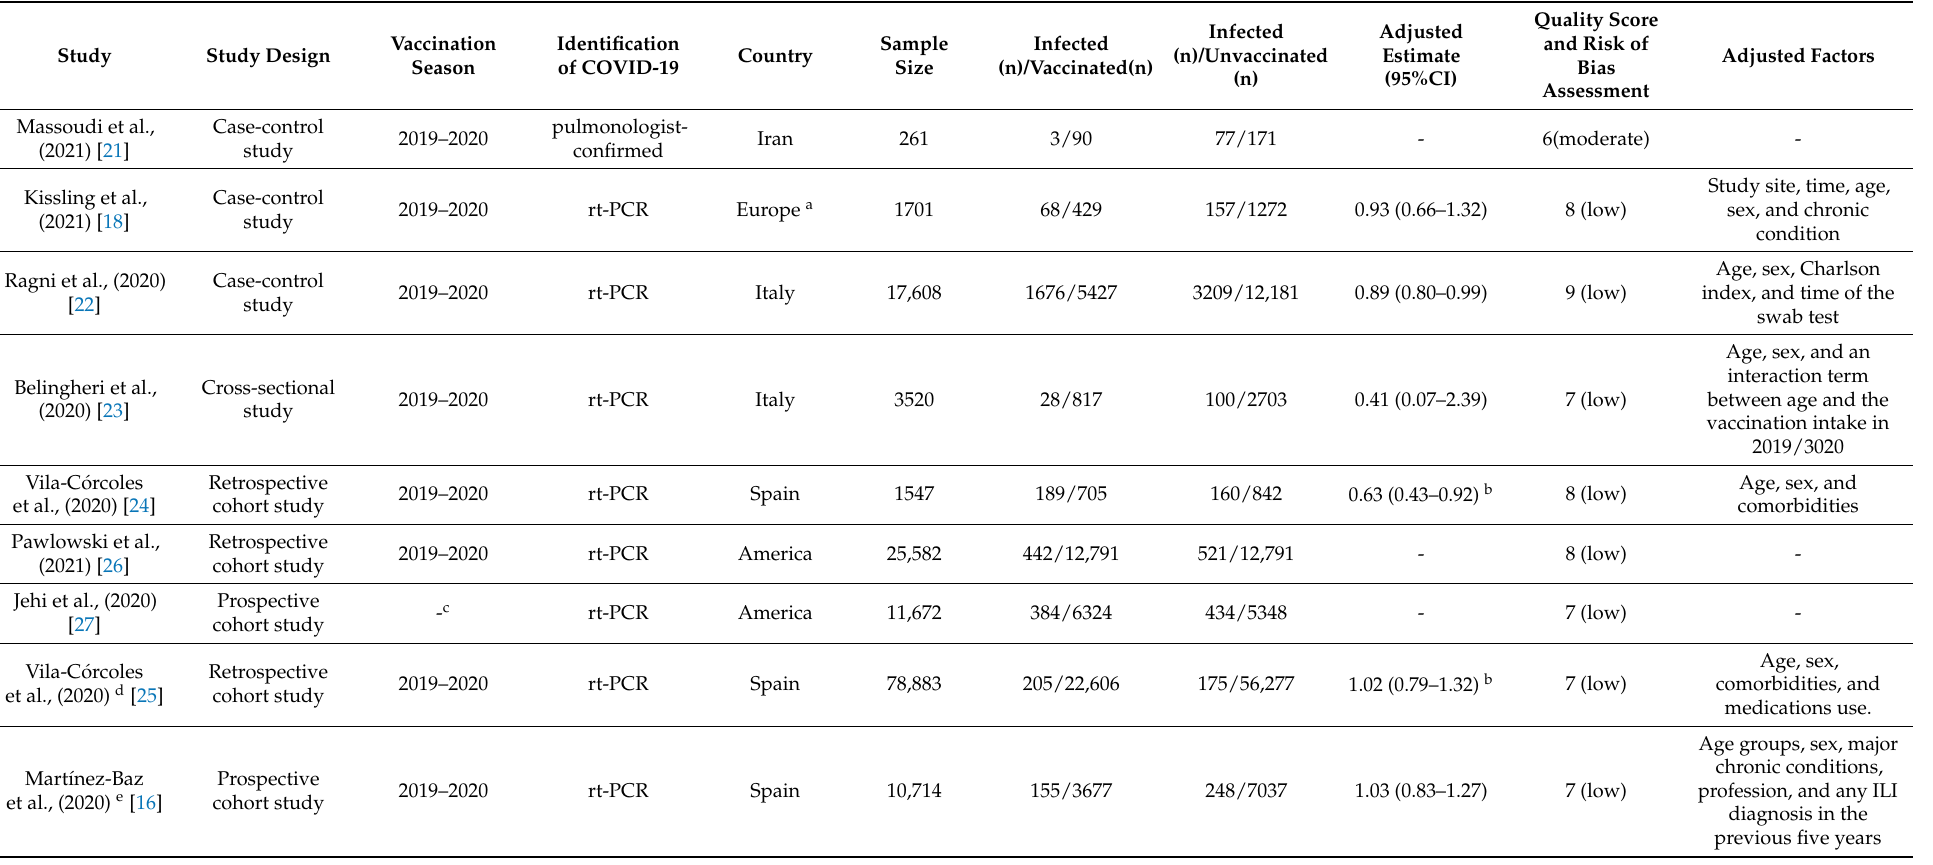
Table 1. Baseline characteristics of the 12 included studies that assessed the association between influenza vaccination and SARS-CoV-2